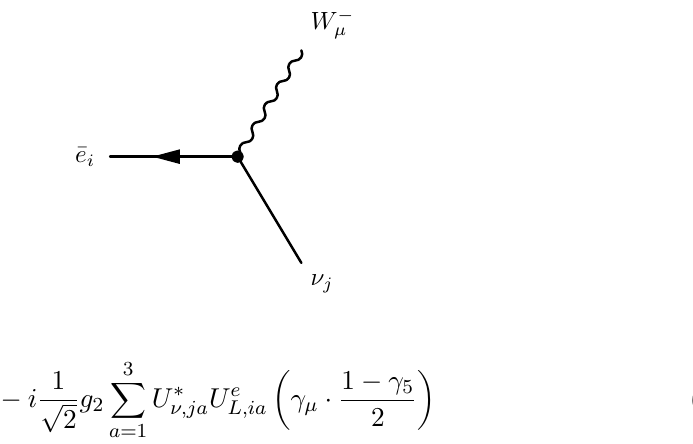
Figure 16. Statistical significance as a function of the classifier score given by NN for each signal graph, assuming the lightest VLQ with mass m T = 2 . 2 TeV and a luminosity L = 3000 fb − 1 . 1 All showcased plots are representative of the best NN found, following an genetic algorithm that maximizes the Asimov significance. For (a) we present the Asimov significance, with 1% systematics, √ s + b and for (c) — the adapted Asimov significance, where for (b) — the standard significance s/ it is assumed that backgrounds are known with error 10 − 3 . to the VLQ pair-production via gluon fusion